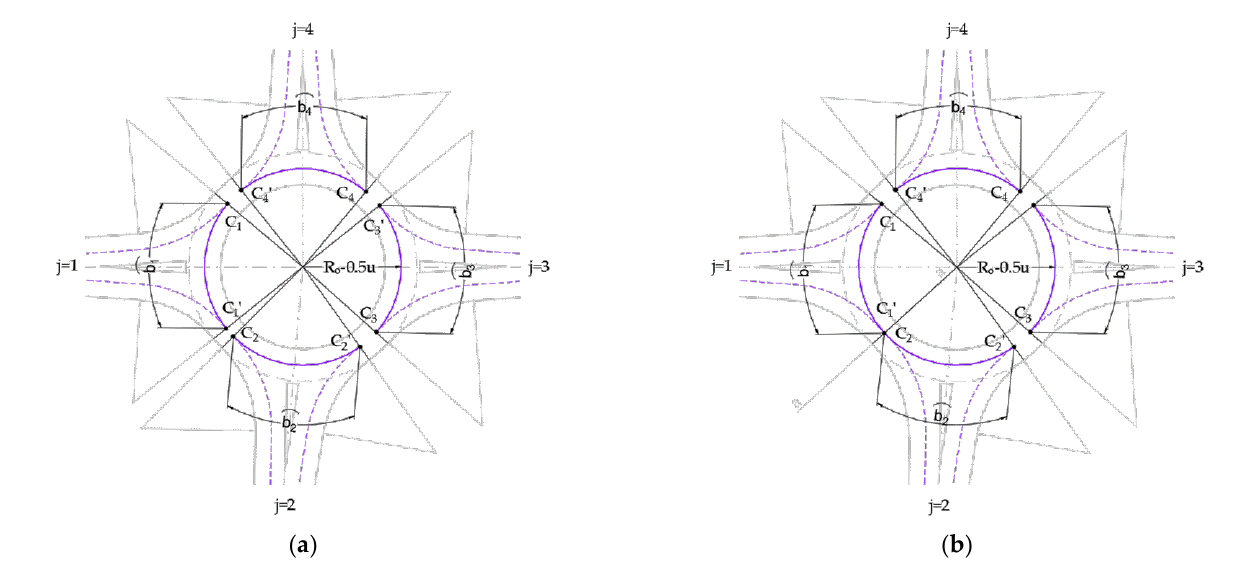
Figure 3. Defining the distance b along the center of the circulatory lane, for roadway right edge design defined by the: ( a ) entry and exit radius; ( b ) design vehicle trajectory.